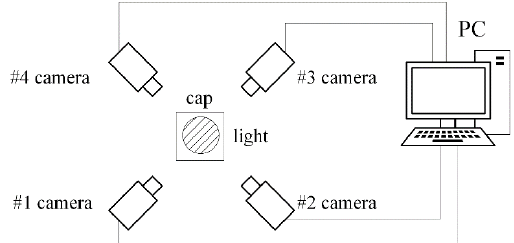
Figure 1. Structure of hardware system.